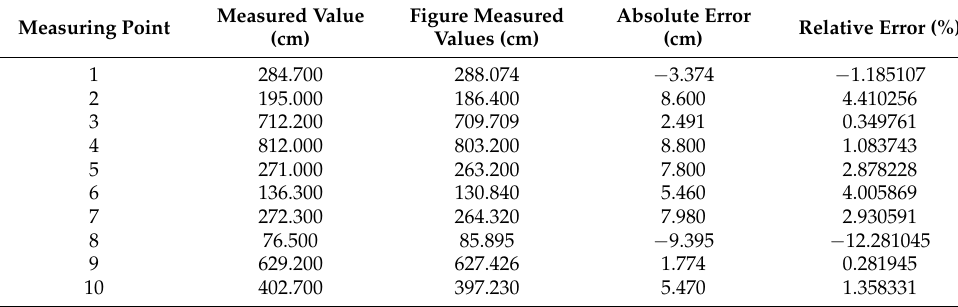
Figure 14. Mapping effect of Iao_ICP. Table 2. Cartographer original algorithm mapping error